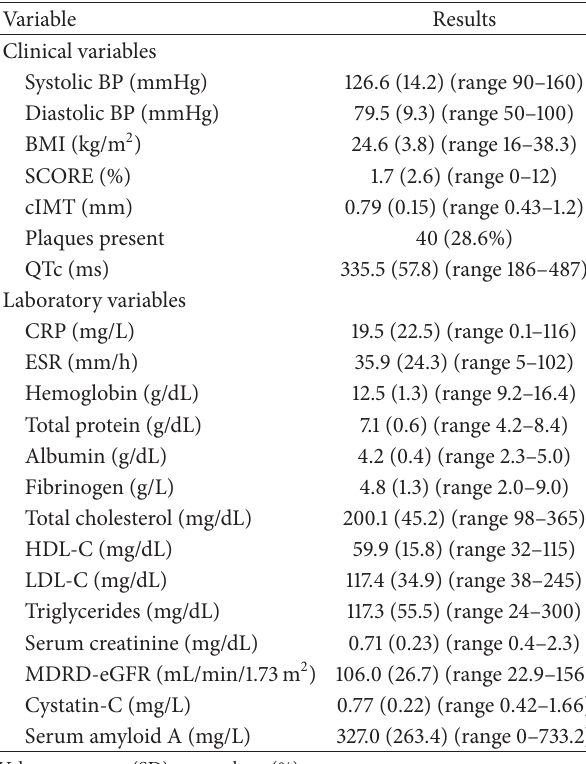
Table 1: Baseline characteristics of 140 RA patients. Table 2: Clinical and laboratory variables in 140 RA